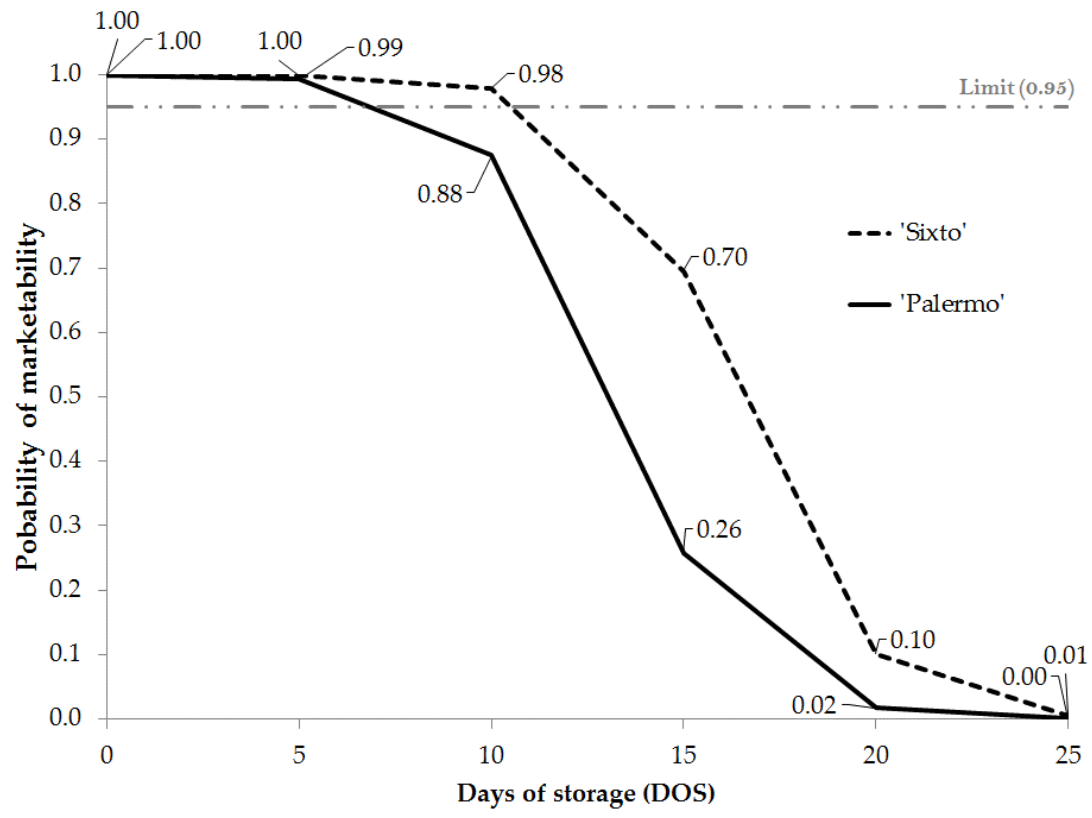
Figure 7. Time evolution of the probability of marketability as a function of the days of storage, as affected by the ‘Sixto’ and ‘Palermo’ pepper cultivars.